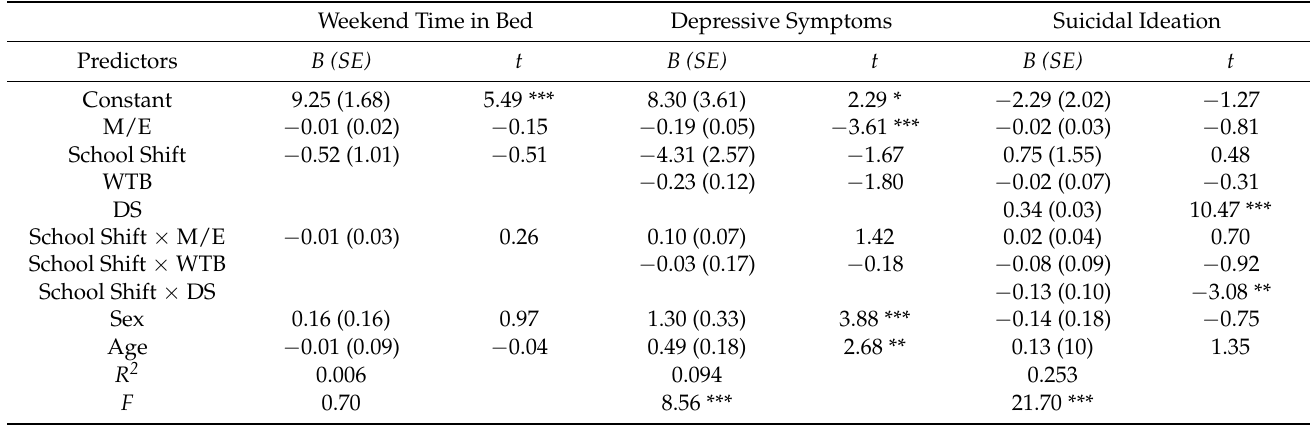
Table 6. Morningness/eveningness (M/E) effect on suicidal ideation through weekend time in bed (WTB) and depressive symptom (DS) mediators, with school shift as moderator and sex and age as covariables. Weekend Time in